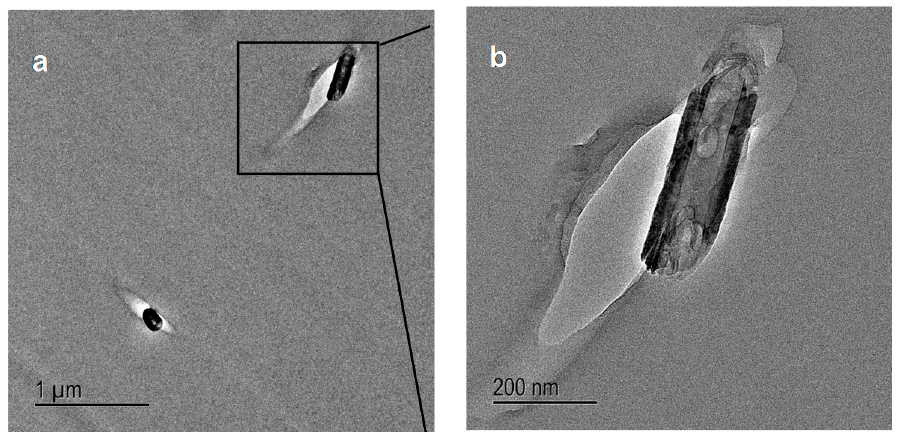
Figure 15. ( a ) TEM micrograph of sub critical point of crack initiation site showing debonding of D-CNF and epoxy; and ( b ) higher magnification of sub critical point of crack initiation site showing debonding of D-CNF and epoxy.